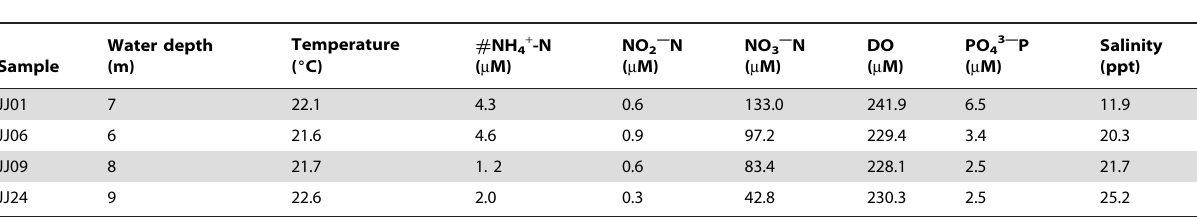
Table 1. The basic physical and chemical parameters of the overlying water of the Jiaojiang Estuary.